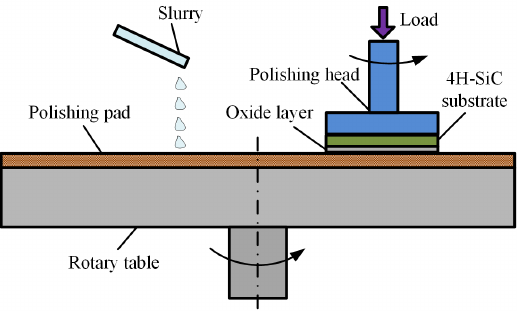
Figure 4. Schematic of mechanical polishing.